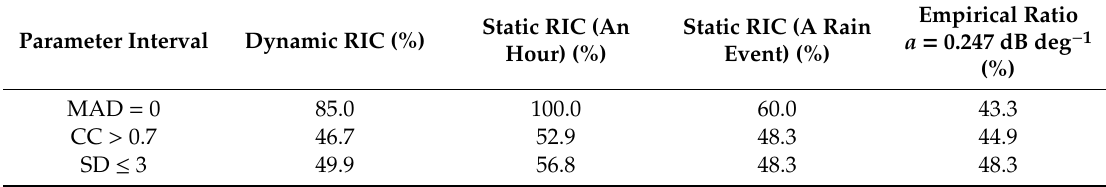
Table 4. Improved percentage di ff erences between results after attenuation correction and results before attenuation